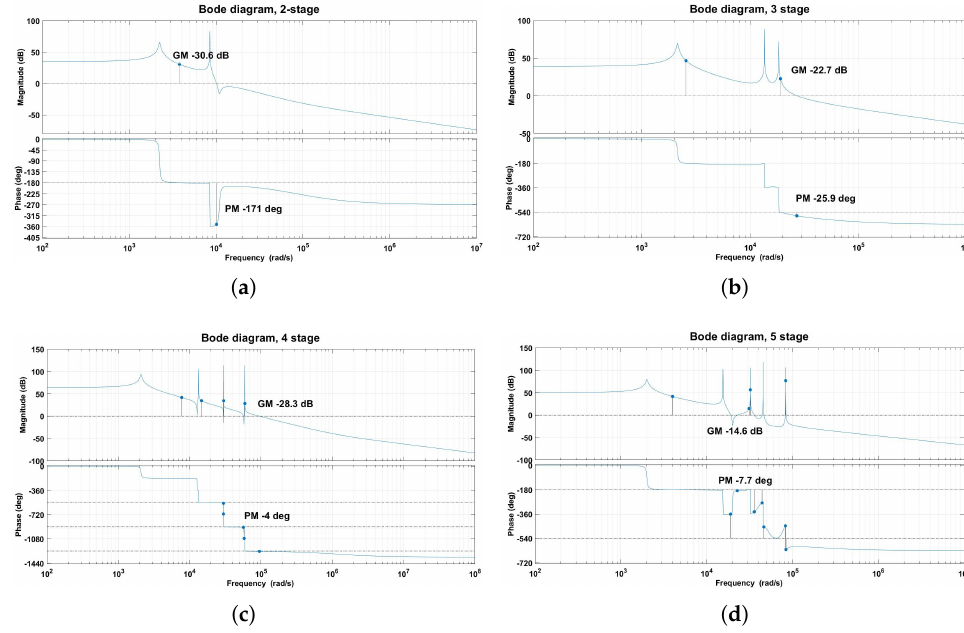
Figure 5. Bode diagram of the single-switch N-stage Z-network high-gain boost converter: ( a ) 2-stage, GM − 30.6 dB, PM − 171 deg; ( b ) 3-stage, GM − 22.7 dB, PM − 25.9 deg; ( c ) 4-stage, GM − 28.3 dB, PM − 4 deg; ( d ) 5-stage, GM − 14.6 dB, PM − 7.7 deg.